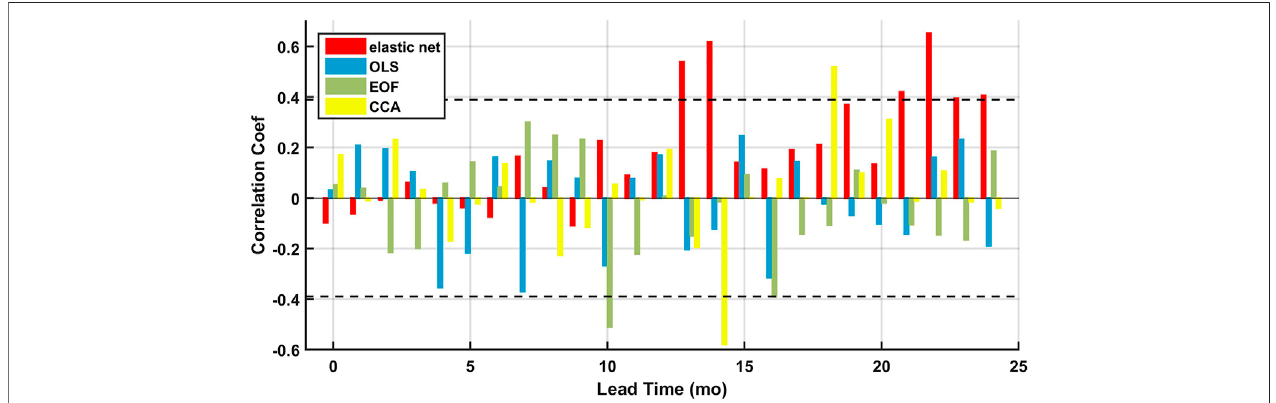
FIGURE5| Predictionskillforthetestingsetof2001 – 2019asmeasuredbythecorrelationcoef fi cientsasfunctionofleadtimesforelasticnet(red),OLS(blue),EOF (green), and CCA (yellow). The p -value (cid:1) 0.1 signi fi cance level is plotted in the black dashed lines.